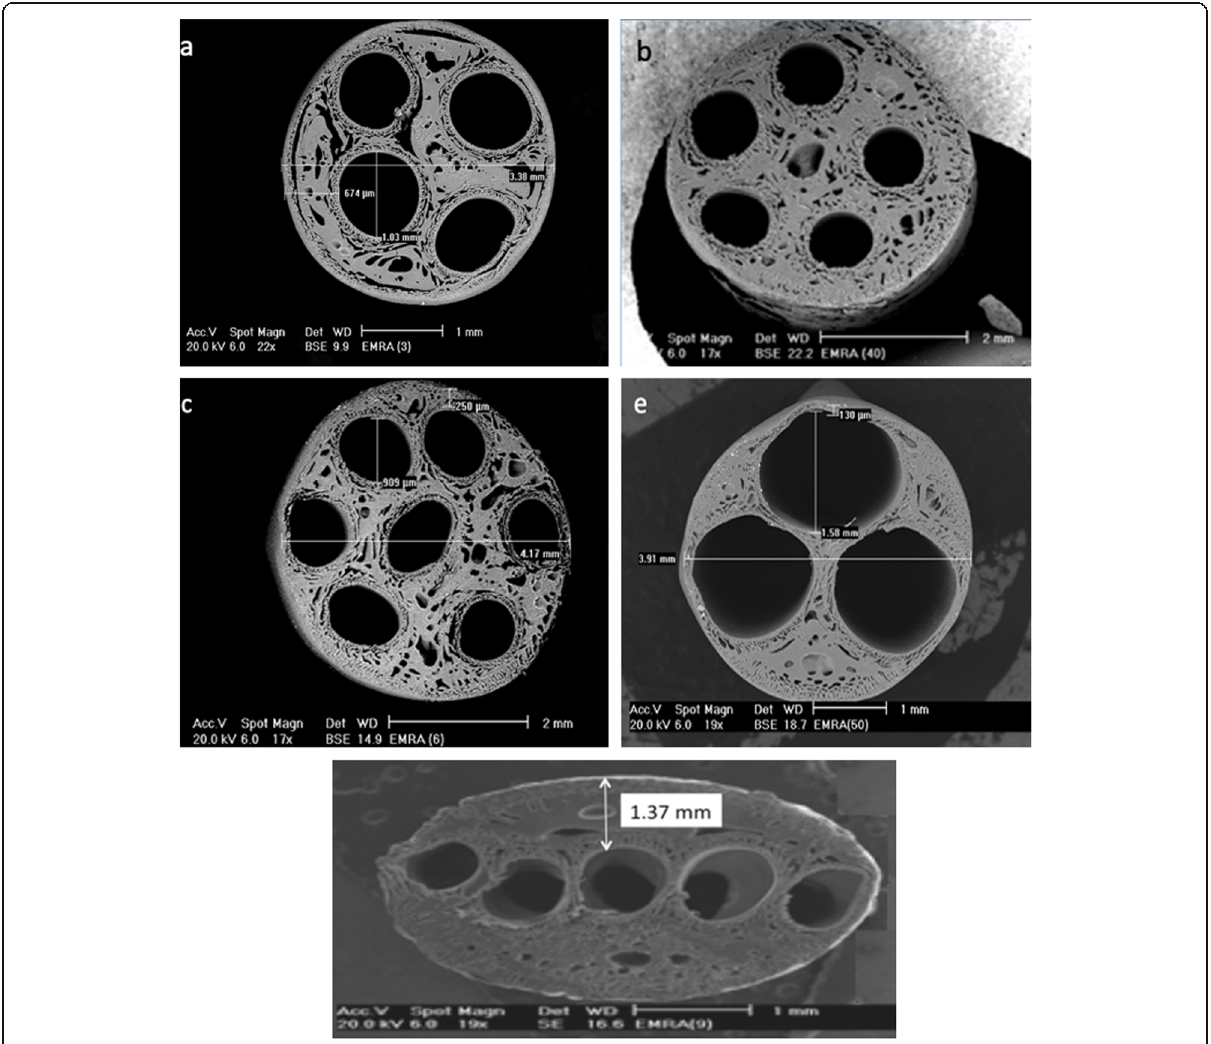
Fig. 7 SEM graphs of different geometrical shapes of MBHF